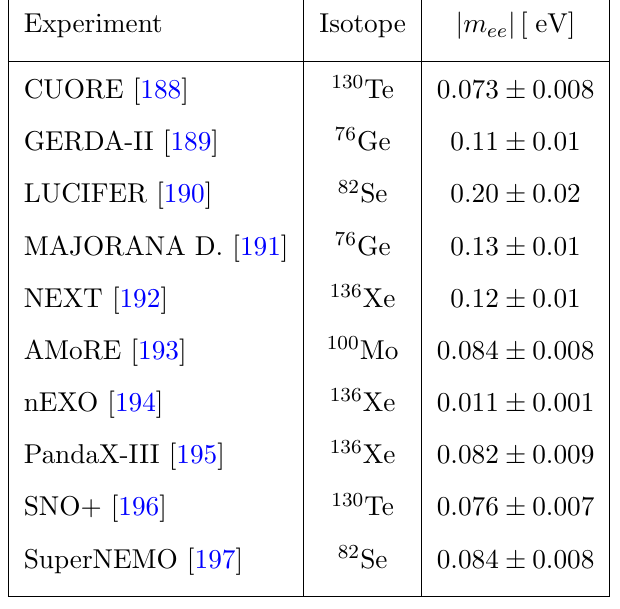
Table 2 . Lower bounds for j m ee j for the next future sensitivities and/or experiments on 0 (cid:23) 2 (cid:12) decay.